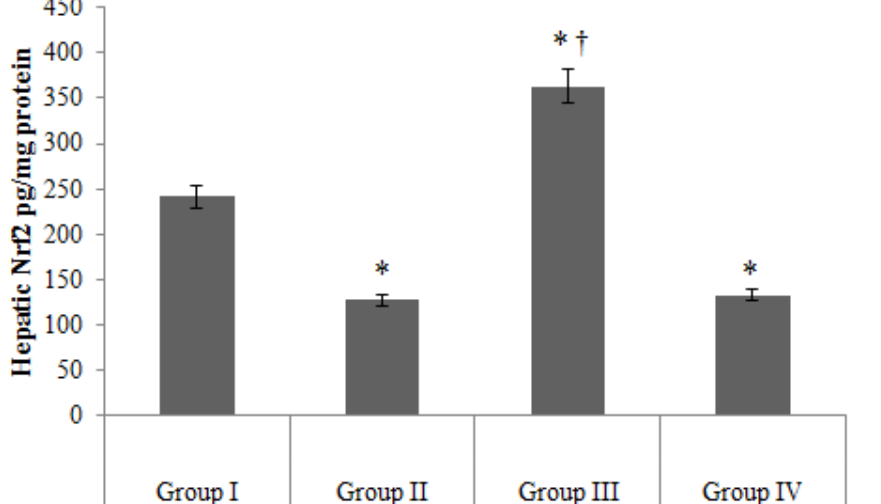
FIGURE 4 - Effects of sitagliptin on APAP-induced alterations in Hepatic Nrf2 levels (pg/mg protein). Group I: normal control group; group II: APAP-treated group; group III: sitagliptin-treated group (10 mg/kg/day) 5 days before APAP administration; group IV: N -acetylcysteine-treated group (100 mg/kg orally). Data are expressed as mean ± SEM for n = 10. * : P < 0.05 compared to normal control group; †: P < 0.05 compared to APAP control group by one-way ANOVA test followed by post hoc